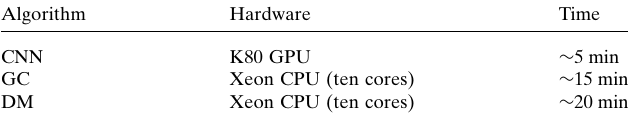
Table 1 Computing-speed comparison.